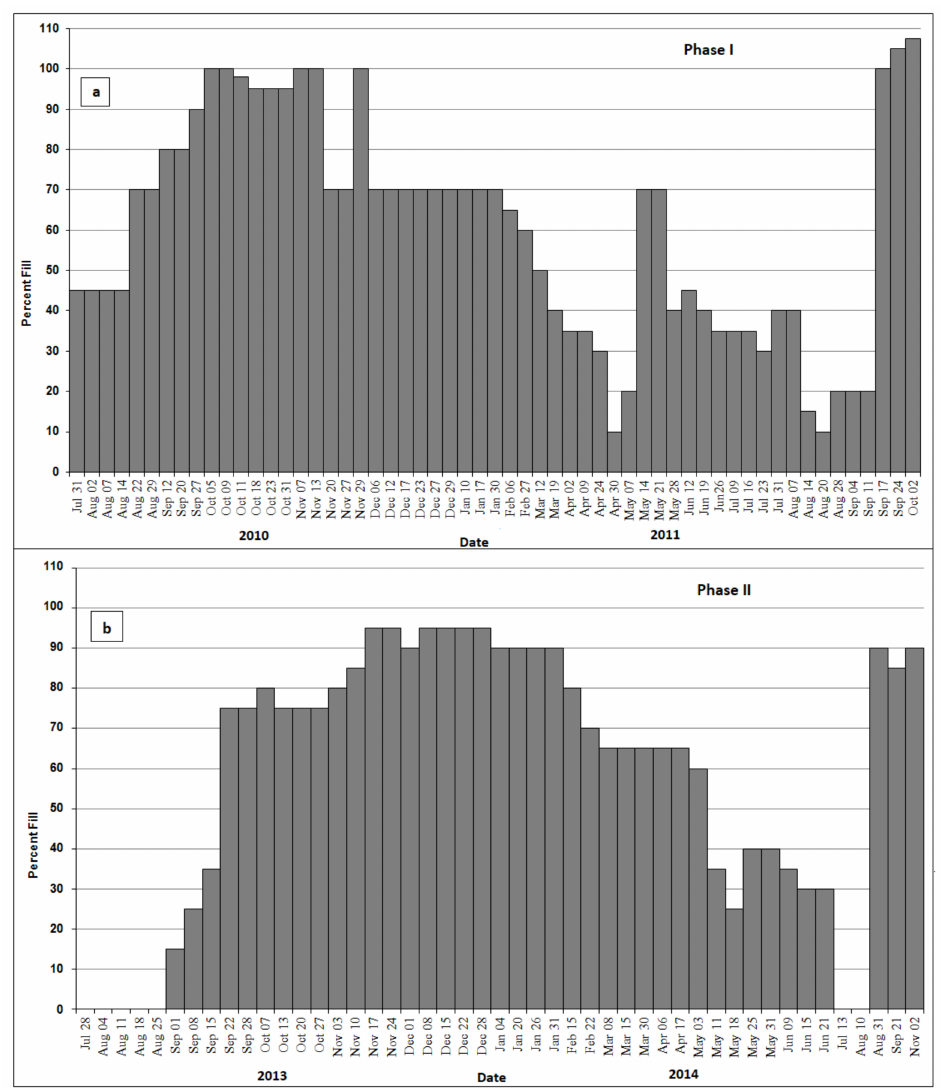
Figure 4. Fluctuations in water levels (% fill) at Laguna Cartagena during ( a ) Phase One of the study (31 July 2010 through 2 October 2011) and ( b ) Phase Two of the study (28 July 2013 through 2 November 2014). The nominal maximum depth is 2.0 m (100% fill), from the lagoon bottom at the 9 m contour, to the maximum lagoon surface elevation at the 11 m